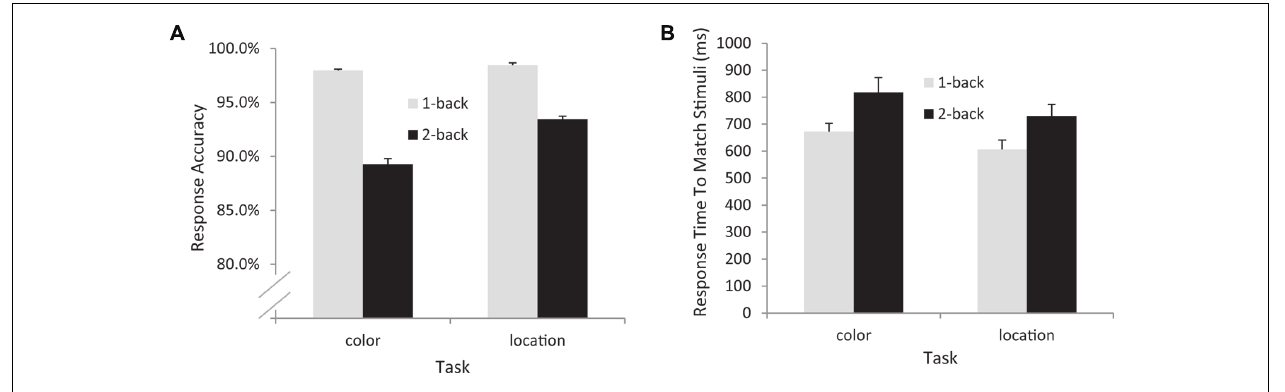
FIGURE 2 | Behavioral data from all participants included in the EEG analyses. Accuracy (A) and response time (B) data. Note that response time data are from correctly detected match trials only.